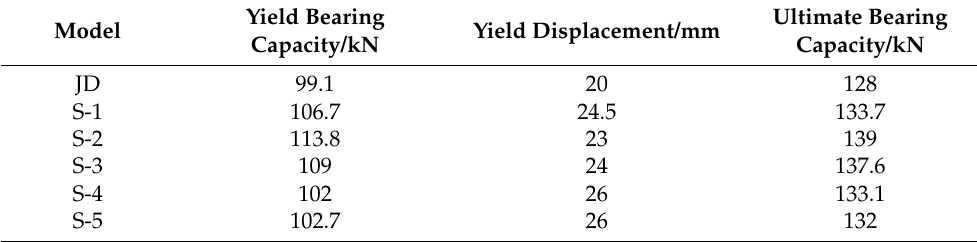
Figure 7. Load ‐ displacement curve under monotonic loading. Table 3. S series and JD joint simulation